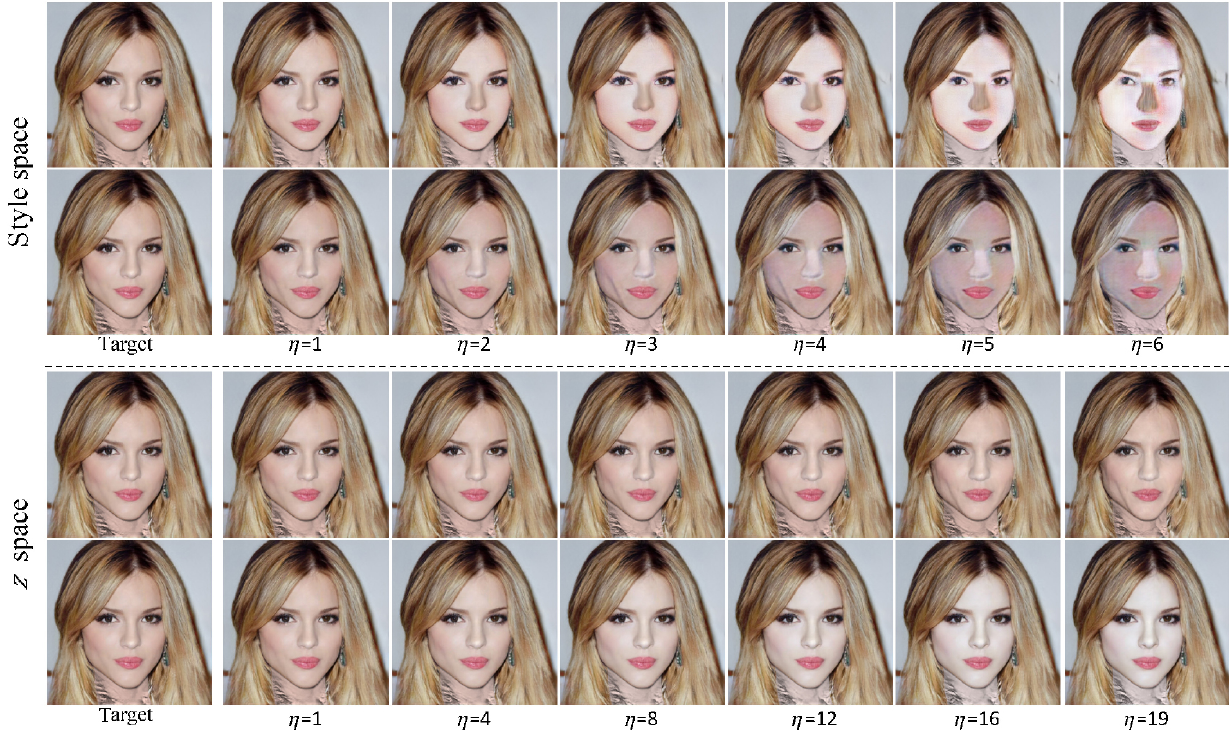
Fig. 9 Two examples of style random fine-tuning for skin in both z and style spaces. Tuning in z space can achieve the goal of convincingly fine-tuning style, such as gradually changing skin color and adding